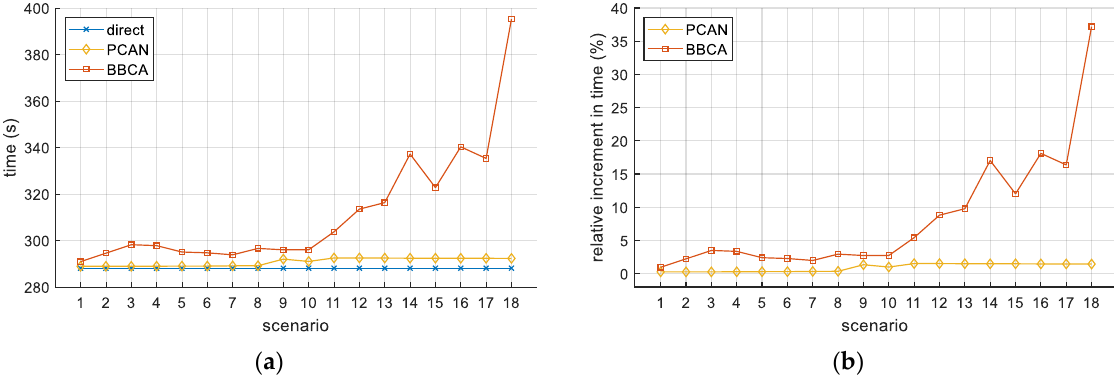
Figure 9. Two-UAV study. Flight time: ( a ) absolute values; ( b ) relative increase with respect to the direct algorithm.